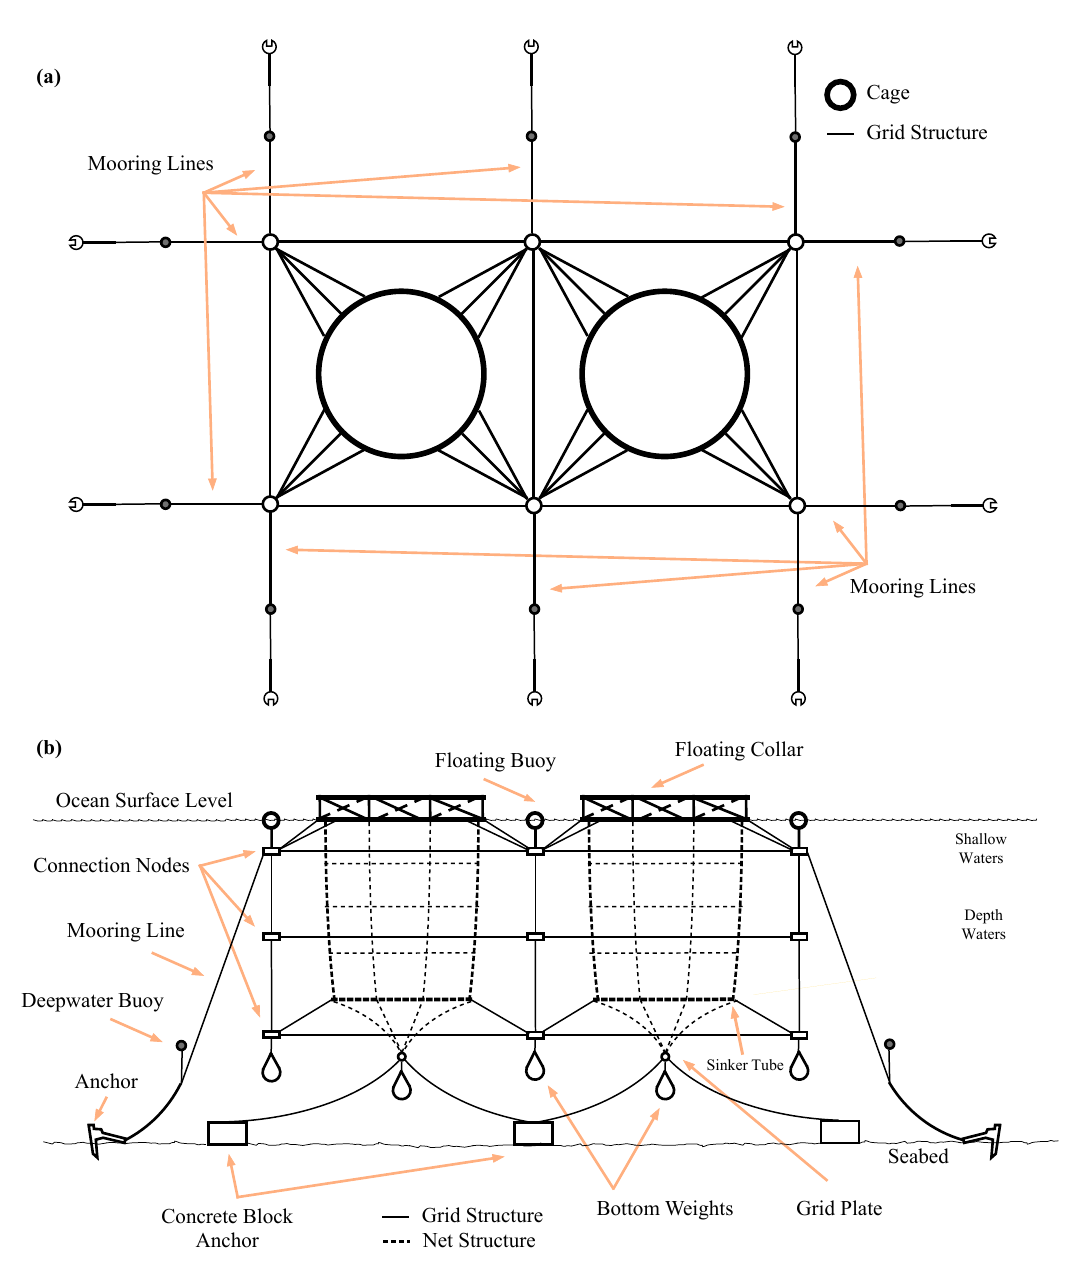
Figure 4. A 2 × 1 offshore aquaculture facility; ( a ) top view; ( b ) lateral view